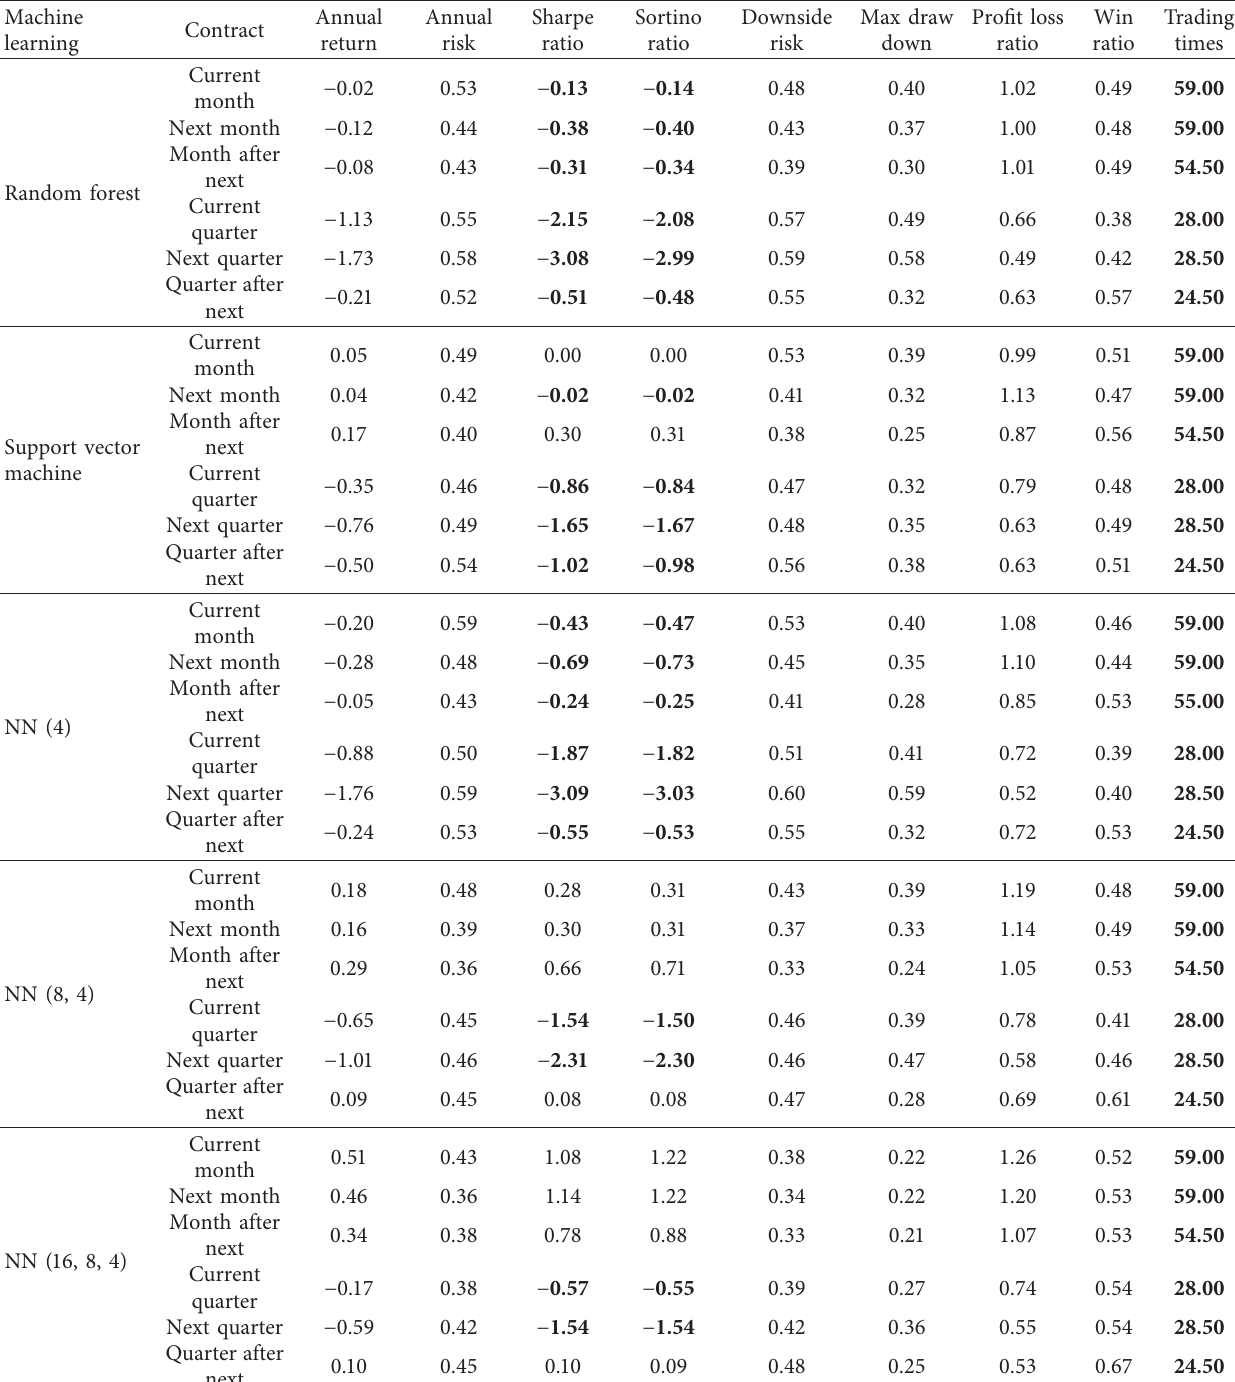
Table 5: Option strategy for directly predicting the rise and fall of volatility (use 21 features M3).